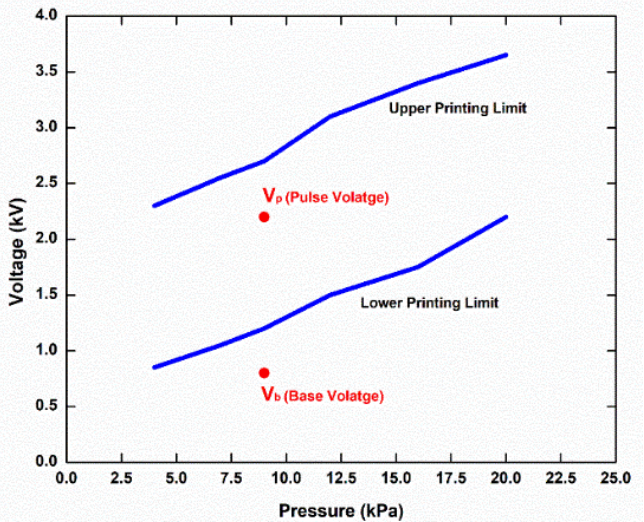
Figure 2. Silver nanoparticle ink operating envelope for steady cone drop/cone generation. Table 1. Optimized experimental parameters for the EHD printing of silver nanoparticle ink.